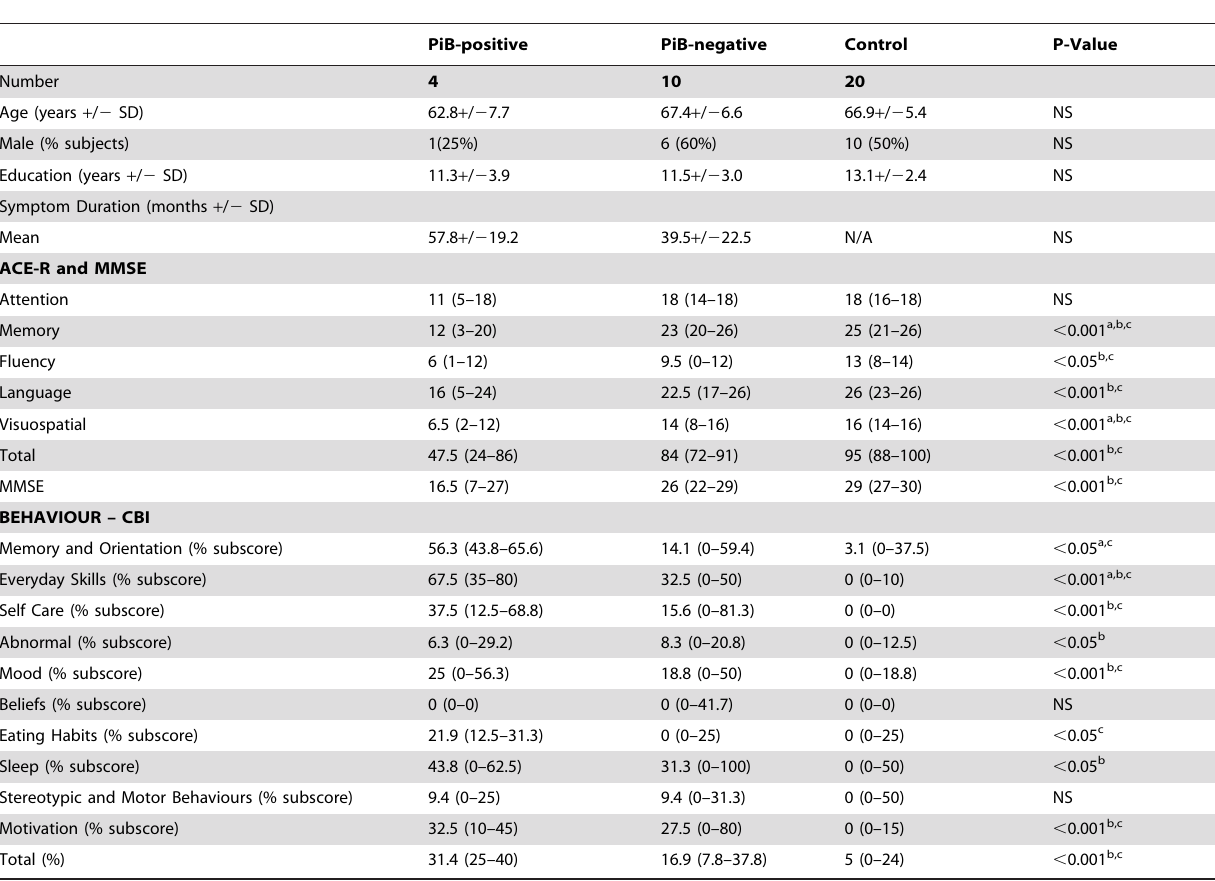
Table 3. Demographic and functional characteristics of CBS patients according to PiB status.